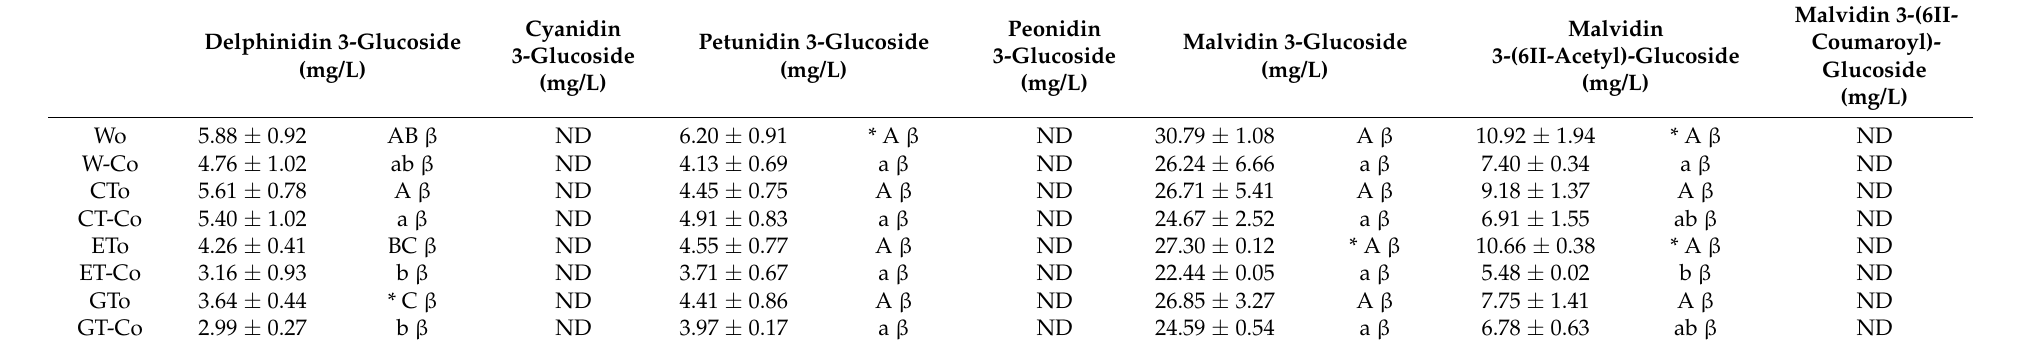
Table 6. Oxidation effect on native